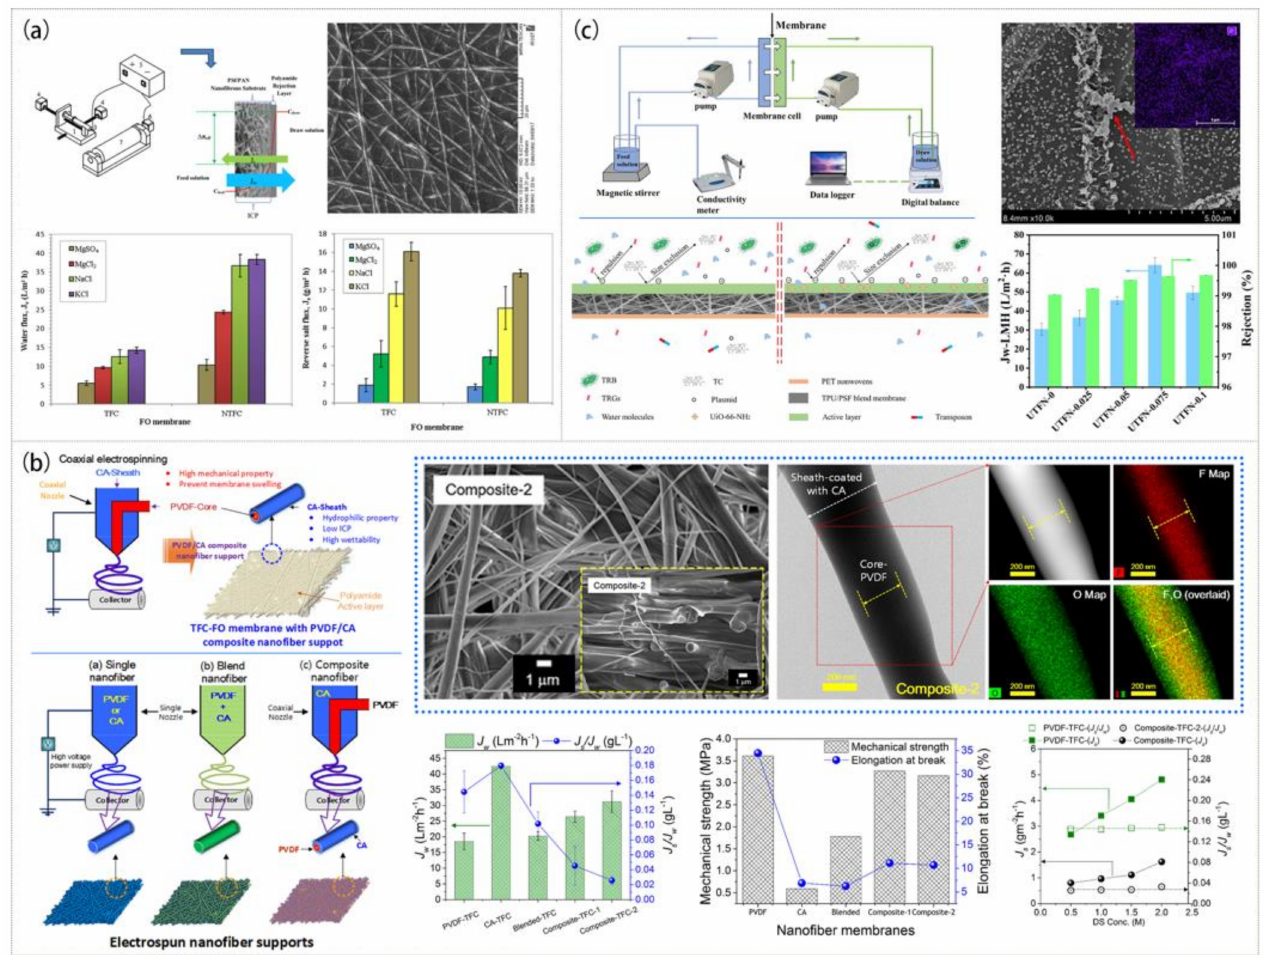
Figure 7. Preparation process, microstructure, and properties of FO membranes: ( a ) PSF/PAN/PA membrane. Reprinted with permission from Ref. [103]. Copyright 2018 Elsevier Ltd. ( b ) CA/PVDF membrane. Reprinted with permission from Ref. [104]. Copyright 2018 Elsevier Ltd. ( c ) TPU/PSF (20/80) membrane. Reprinted with permission from Ref. [106]. Copyright 2020 Elsevier